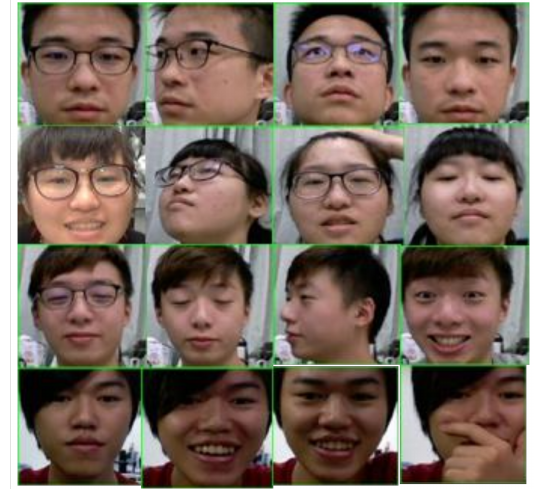
Figure 14. A collection from a self-collected, non-public